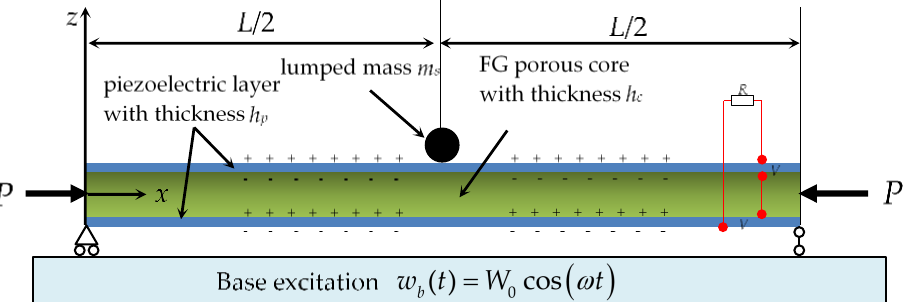
Figure 1. Sketch of a piezoelectric energy harvester with a simply supported nanobeam settled on base.